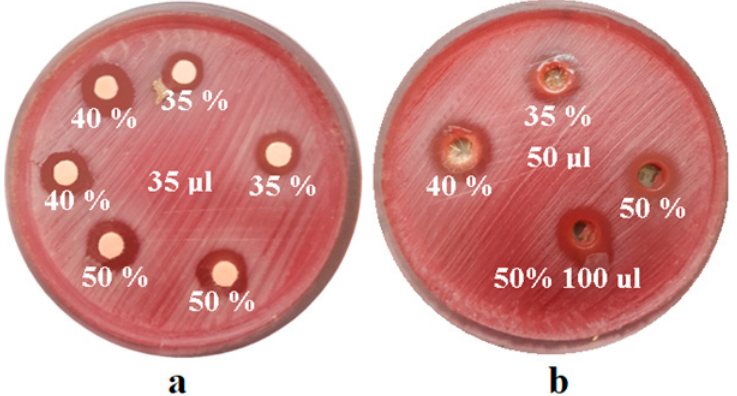
Figure 2. Corynebacterium xerosis culture inhibition diameters when inoculating 35 µl of 35%, 40% and 50% extract ( a ) and Corynebacterium xerosis culture inhibition diameters when inoculating 50 µl of 35%, 40% and 50% extract, as well as 100 µl extract 50% ( b ).